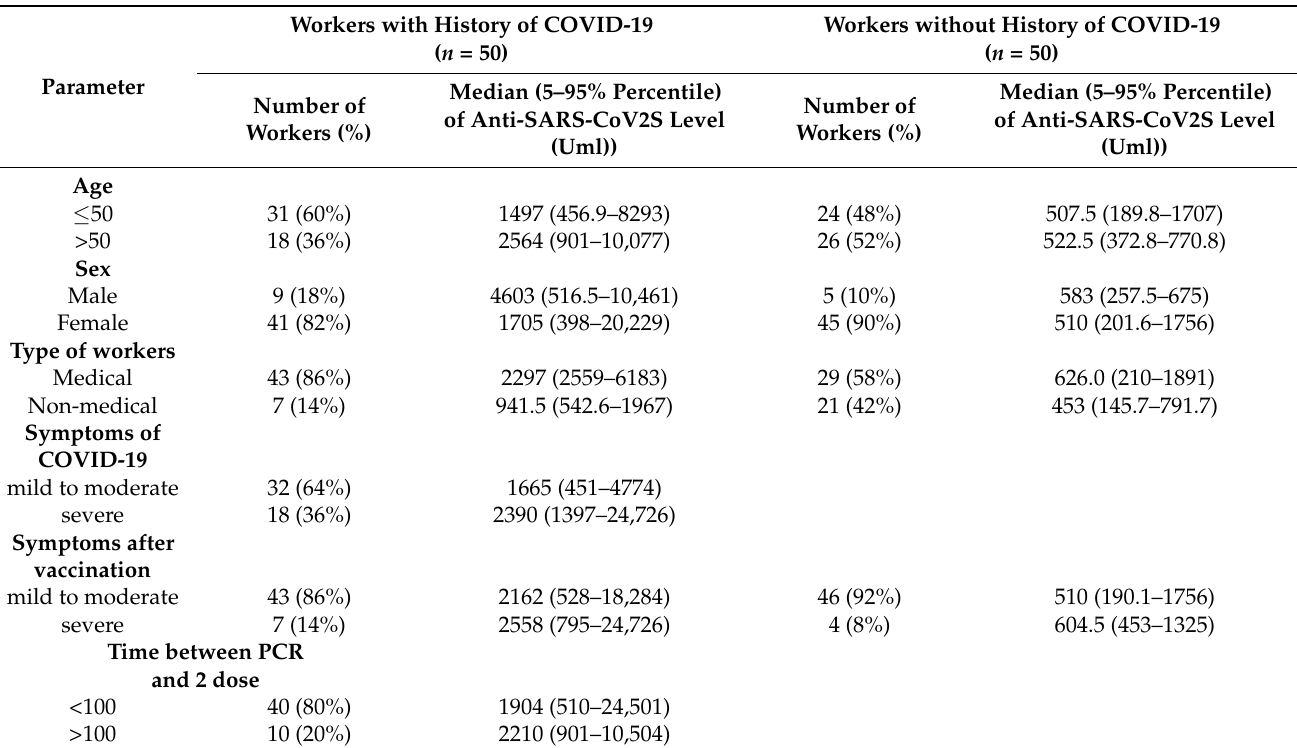
Table 1. Characteristics of study